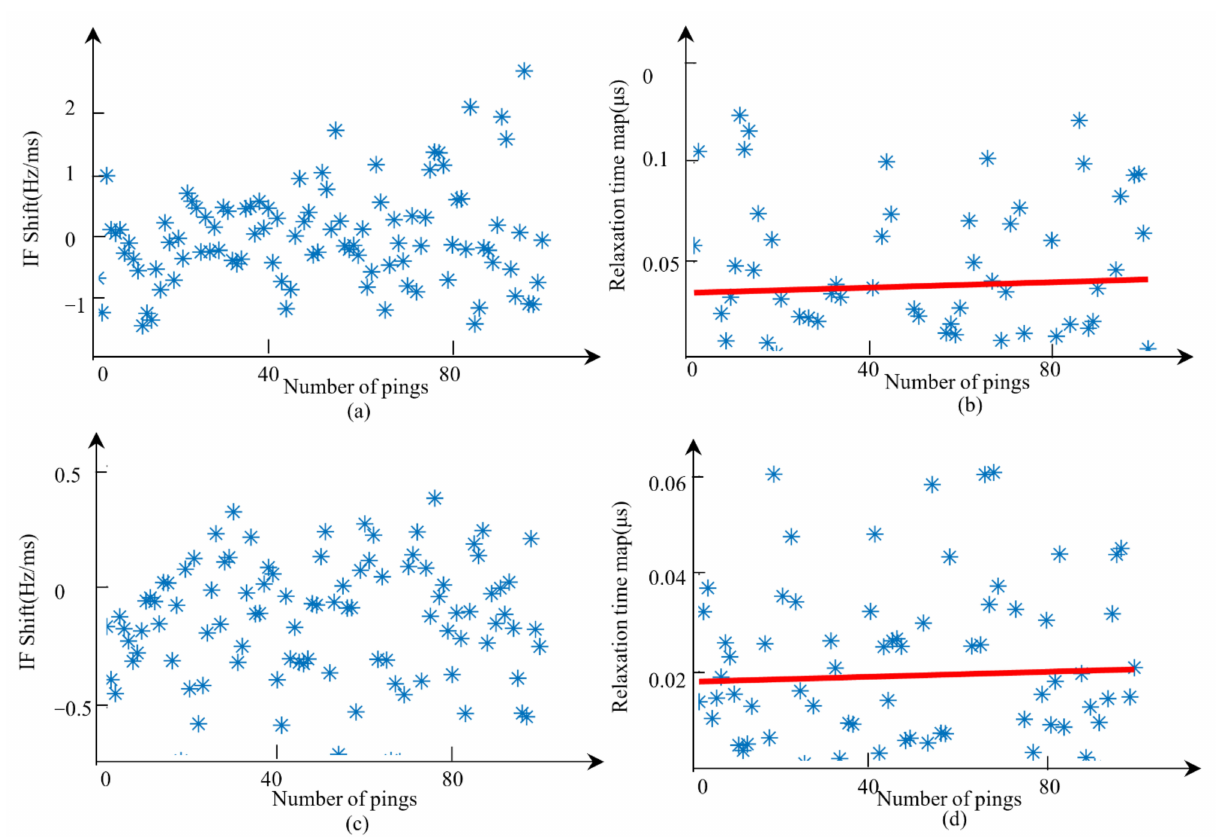
Figure 11. Illustration of the IF series and the relaxation time map. ( a ) The IF shift data of 101 pings of the first layer. ( b ) The robust line fitting based on a relaxation time map of the first layer. ( c ) The IF shift data of 101 pings of the second layer. ( d ) The robust line fitting based on a relaxation time map of the second